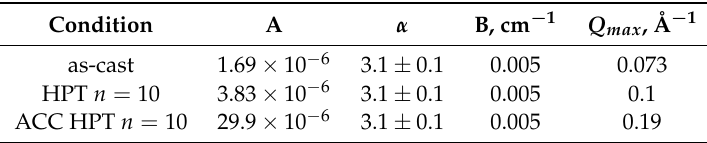
Table 5. The results of experimental data fit with